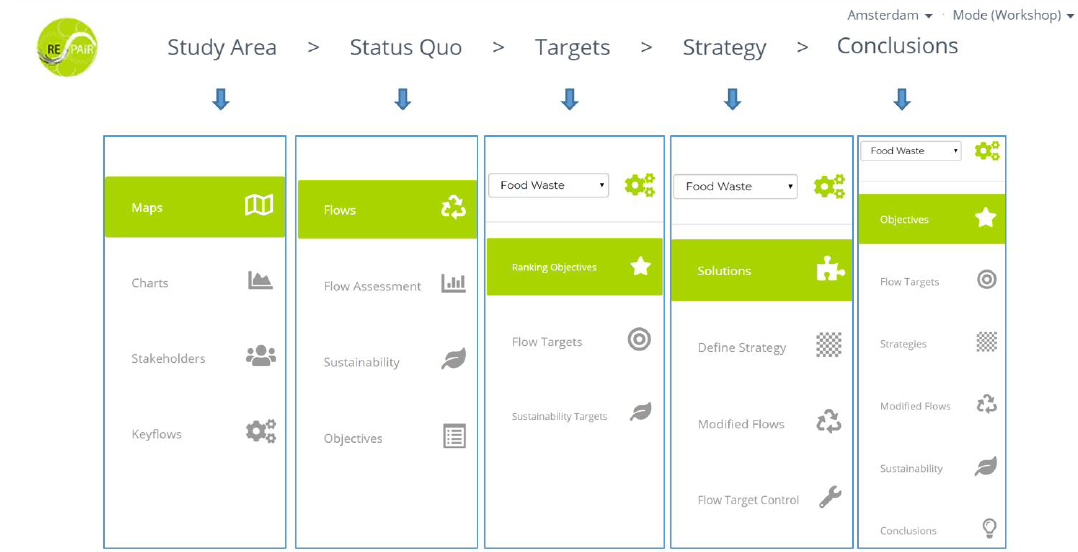
Figure 4. Screenshot of the GDSE showing its main five steps (top) and specific side menus (REPAiR, 2018b).